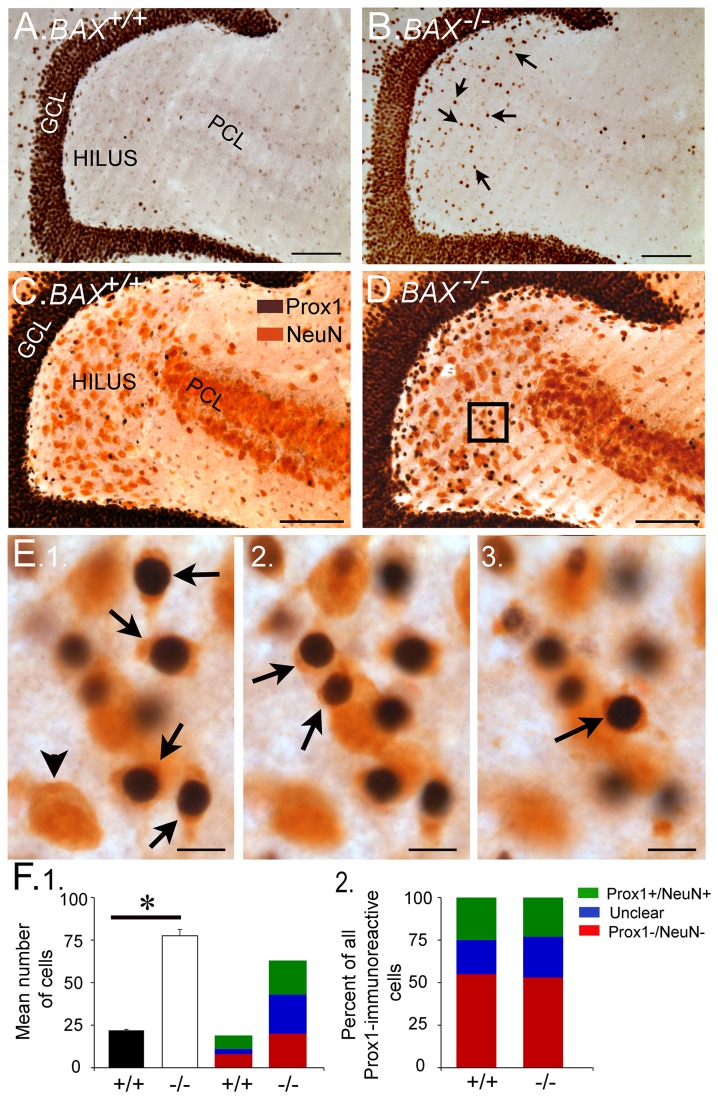
Prox1-ir cells in BAX+/+ and BAX-/- mice.
A-B. Representative horizontal sections illustrate Prox1-ir nuclei in the hilus of a BAX+/+ (A) and BAX-/- mouse (B) at 2 months of age. Arrows point to Prox1-immunoreactive nuclei in the hilus. GCL = granule cell layer. PCL = CA3 pyramidal cell layer. Calibration in A-D = 100 µm. C-D. Prox1 and NeuN labeling in a BAX+/+ and BAX-/- mouse (D). The area surrounded by the box is enlarged in E. E. 1-3. Double-labeled cells (Prox1+/NeuN+) are indicated by the arrows. Prox1 labels the nucleus and NeuN labels the cytoplasm, which come into focus in the same focal plane when the cell is double-labeled. Successive focal planes are shown in 1-3. This area corresponds to the boxed area in D. The arrowhead denotes a NeuN+ cell that was not labeled by Prox1. Calibration = 15 µm. F. Quantification of the Prox1-labeled and NeuN-labeled cells. 1. The mean number of double-labeled hilar cells in BAX-/- mice (white bar) was significantly greater (p<0.05; asterisk) than double-labeled hilar cells in BAX+/+ mice (black bar). The mean numbers of double-labeled (Prox1+/NeuN+; green) and Prox1+/NeuN-cells (red) are also shown. There also was a subset of Prox1+ cells that could not be classified definitively (as NeuN+ or NeuN-) because they were located in a cluster of overlapping Prox1-ir cells, or the cytoplasm showing NeuN-ir was small. 2. There were similar proportions of Prox1+ cells that were NeuN+, regardless of the genotype.